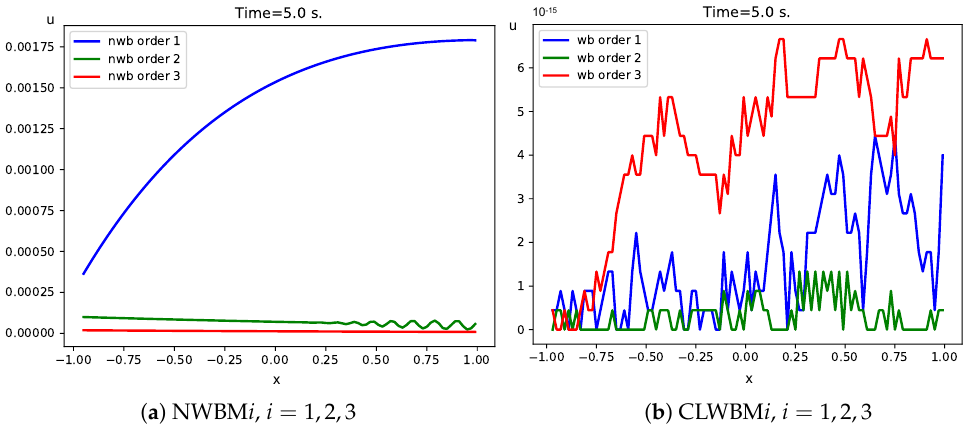
Figure 2. Test 2.1. Differences between the stationary and the numerical solutions at t = 5 s using a mesh with 100 cells. Table 5. Test 2.1. Differences in L 1 -norm with respect to the stationary solution and convergence rates for NWBM i , i = 1,2,3.